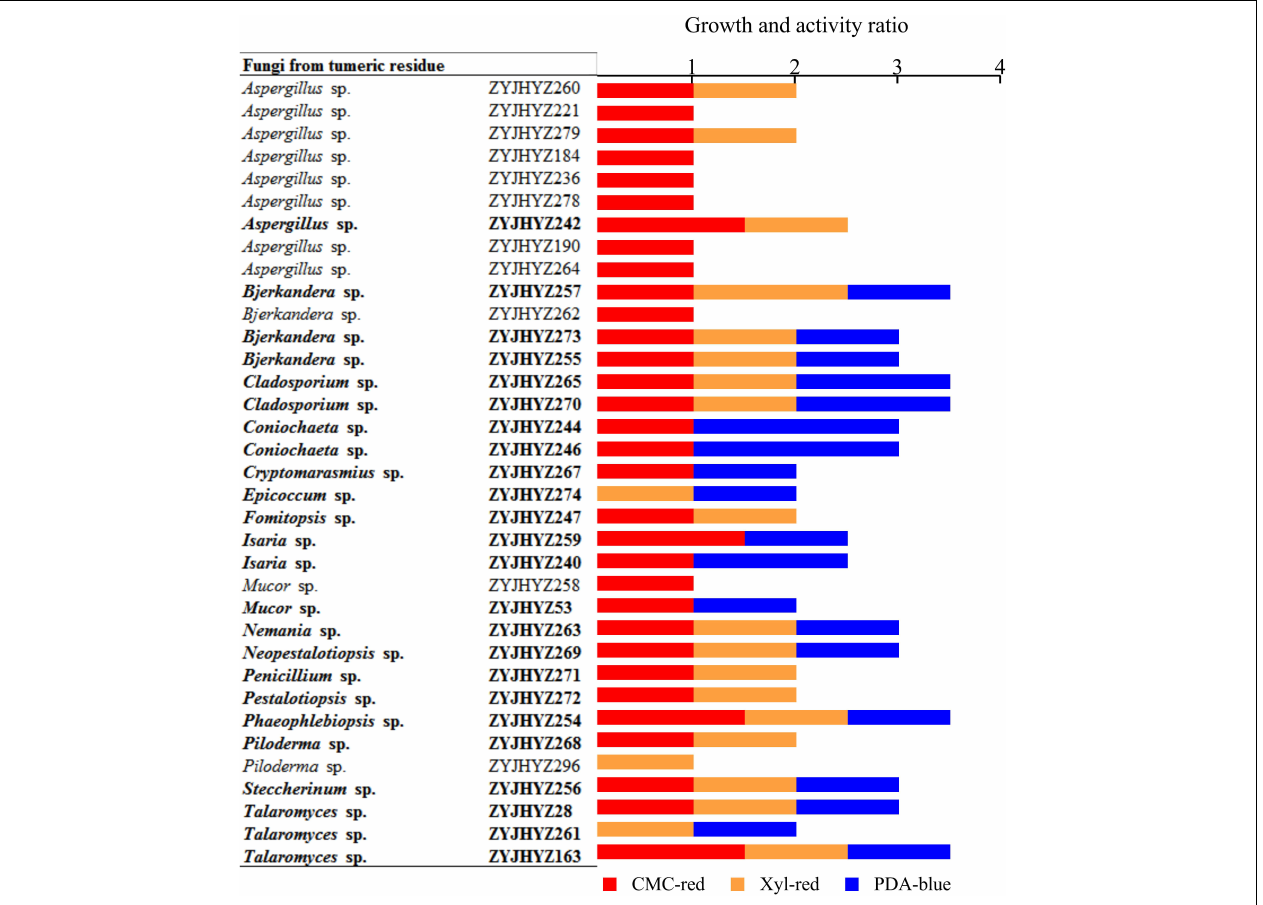
FIGURE 2 | Growth and activity ratio of the selected fungi grown on solid media. The media contains 1% cellulose (CMC-red), 0.5% xylan (Xyl-red) or 0.01% aniline blue (PDA-blue). Fungi in bold showed > 2.0 growth ratio and were chosen for cultivation in liquid media. The growth and activity ratio was estimated by hydrolytic diameter/colony diameter after 5